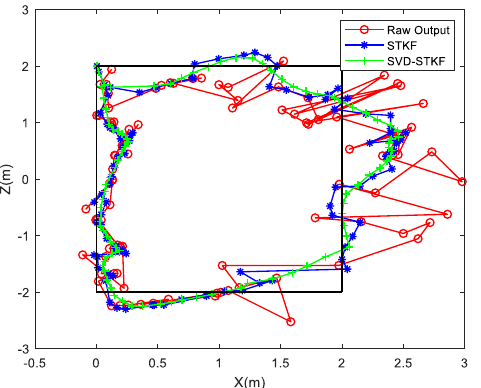
Figure 18. Trajectory comparison of the dynamic experiment.